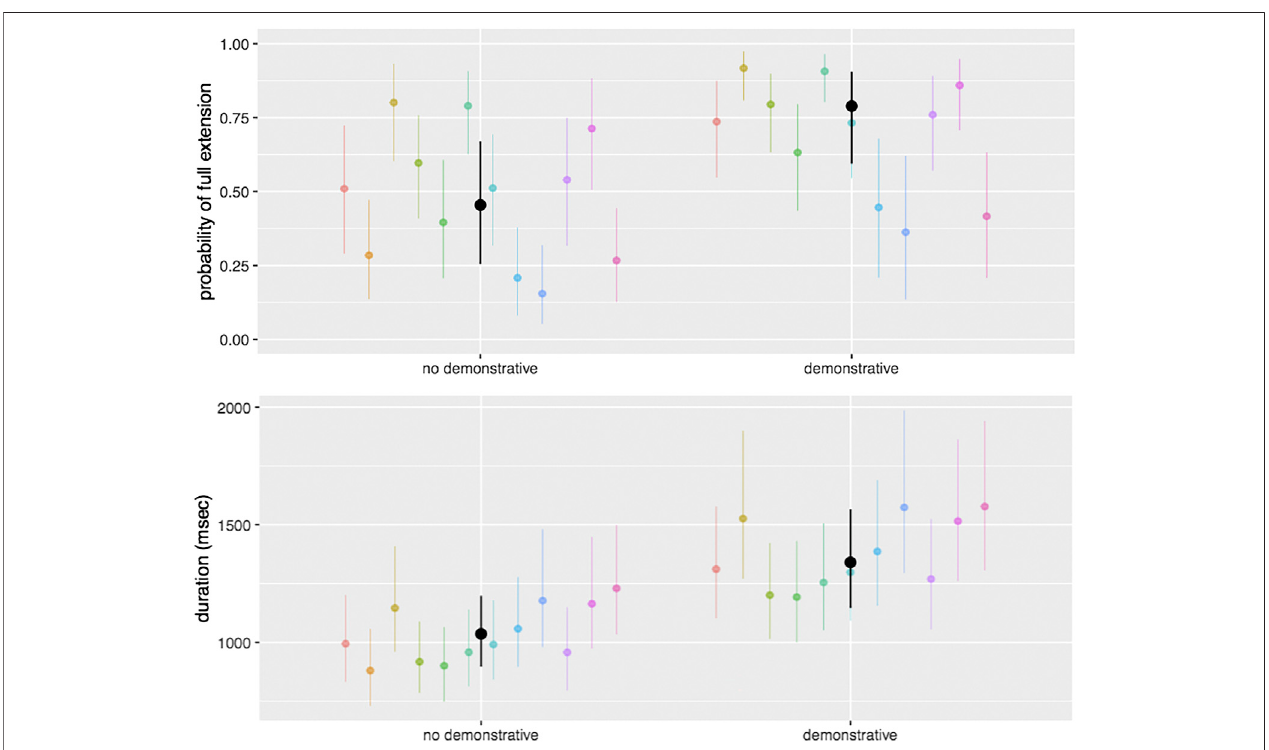
FIGURE 5 | Results from a model of speakers only, predicting the probability of full arm extension (top) and duration (bottom) as a function of whether or not a point is associated with a spoken demonstrative ( this, that, here, there ). Points that were associated with a demonstrative were more likely to involve full arm extension, and were longer in duration, than points that were not associated with a demonstrative. Black dots represent overall means and black lines represent 95% con fi dence intervals around those means; colored dots and lines represent individual participants.